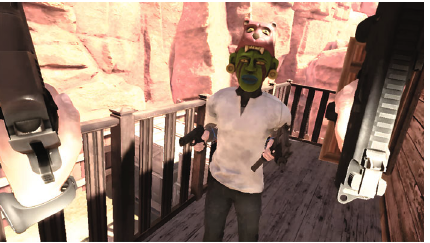
Figure 4: First-person perspective. Arizona Sunshine. Desaturated to enhance